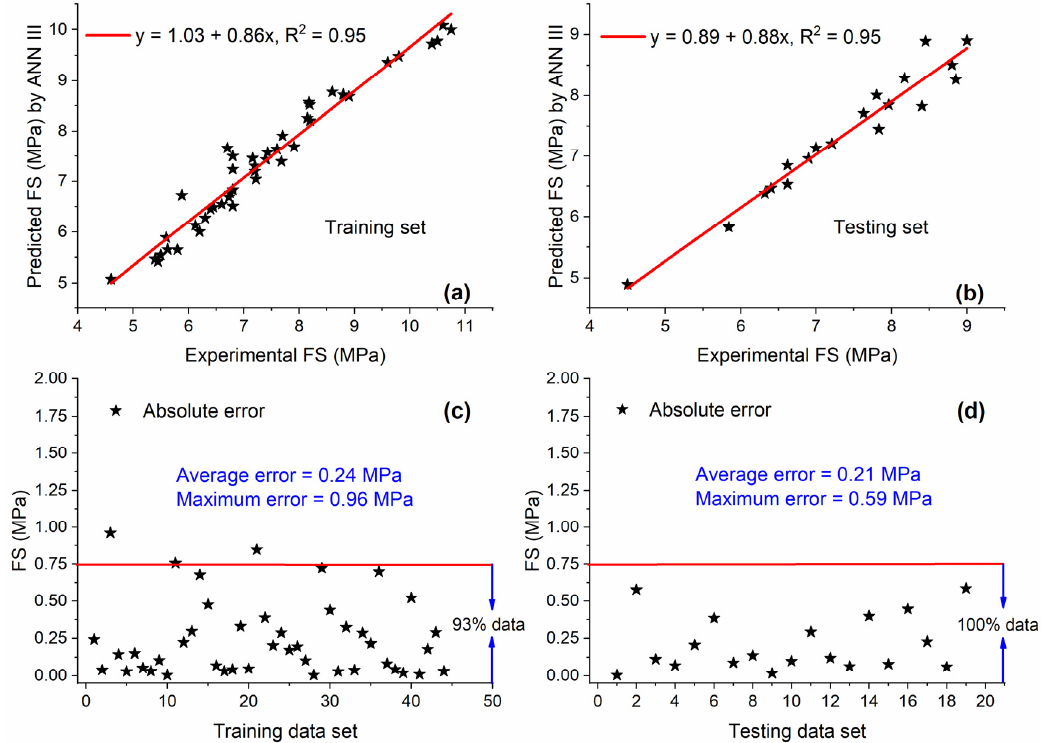
Figure 20. Experimental and predicted values of FS by ANN III for ( a ) training set and ( b ) testing set, and their corresponding absolute error for ( c ) training data set and ( d ) testing data set.